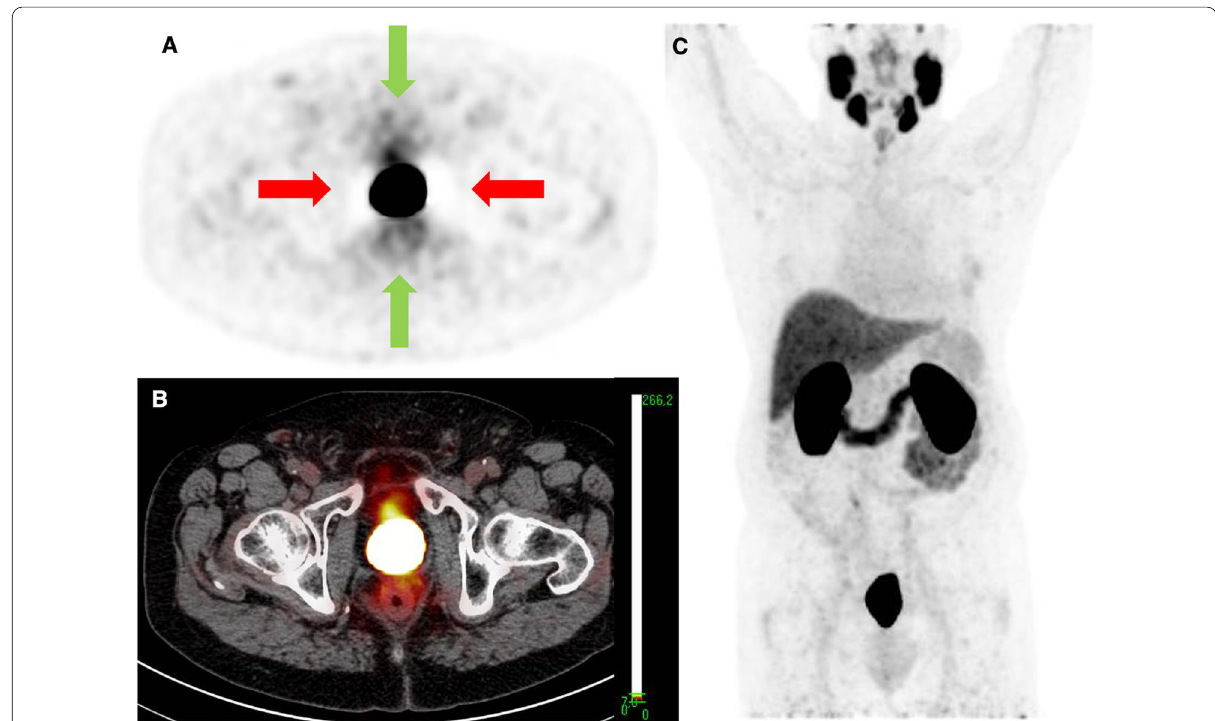
Fig. 2 PSMA PET/CT with 18 F‑DCFPyL used as tracer in a 68 years old man staged for staging of biochemical recurrence of prostate cancer showing peri‑bladder artefacts, deteriorating image quality and impairing image interpretation. A Axial PET reconstructions; B fused axial PET/ CT reconstructions; and C PET maximum intensity projection (MIP). Window width SUV range 0–7 applied. Red arrows: PET photopenic area (halo artefact). Green arrows: increased PET activity (flare